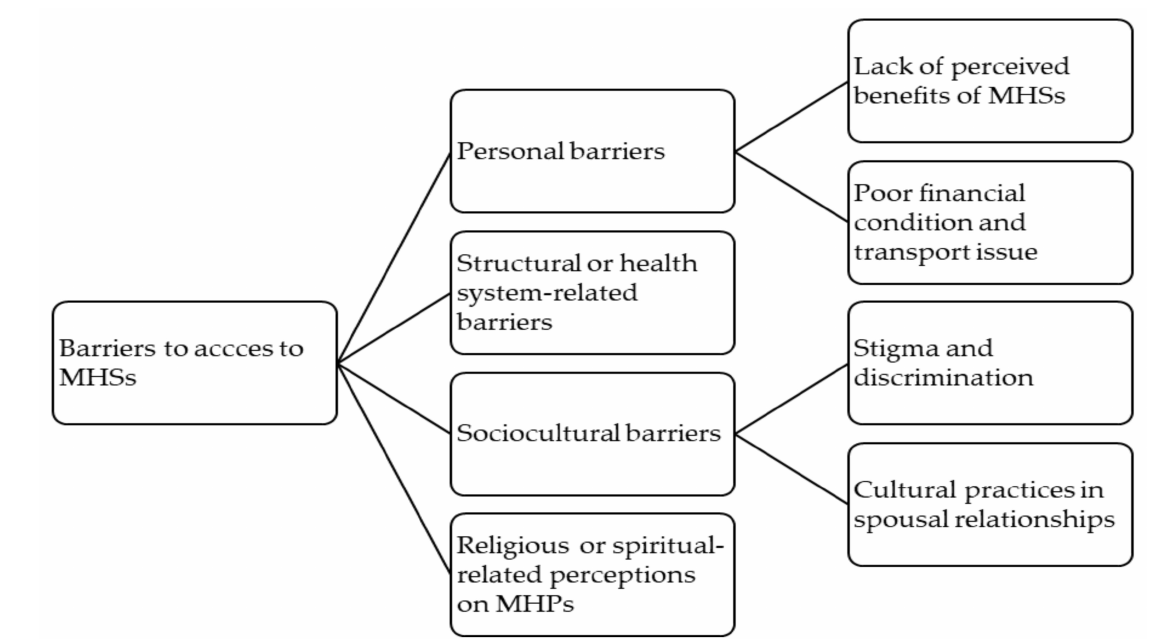
Figure 1. Coding tree with the main themes and